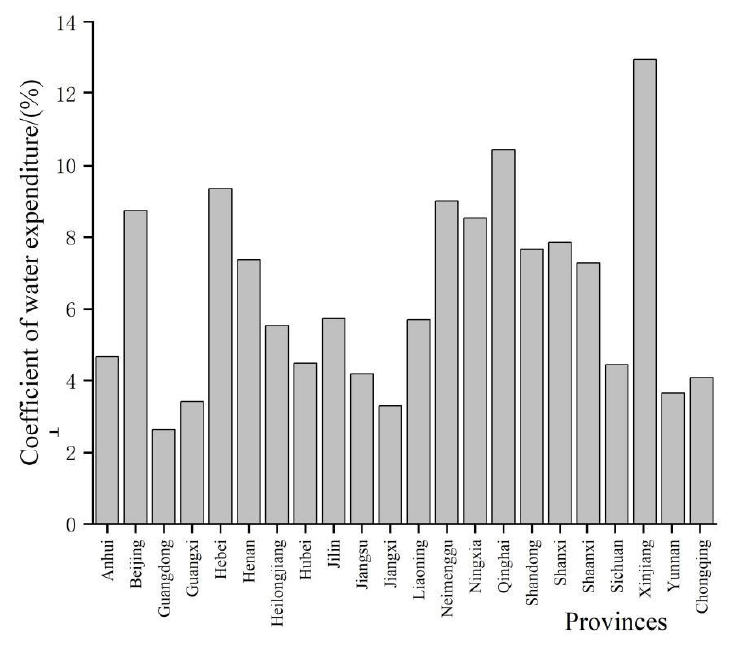
Figure 1. WEC. Figure 1.